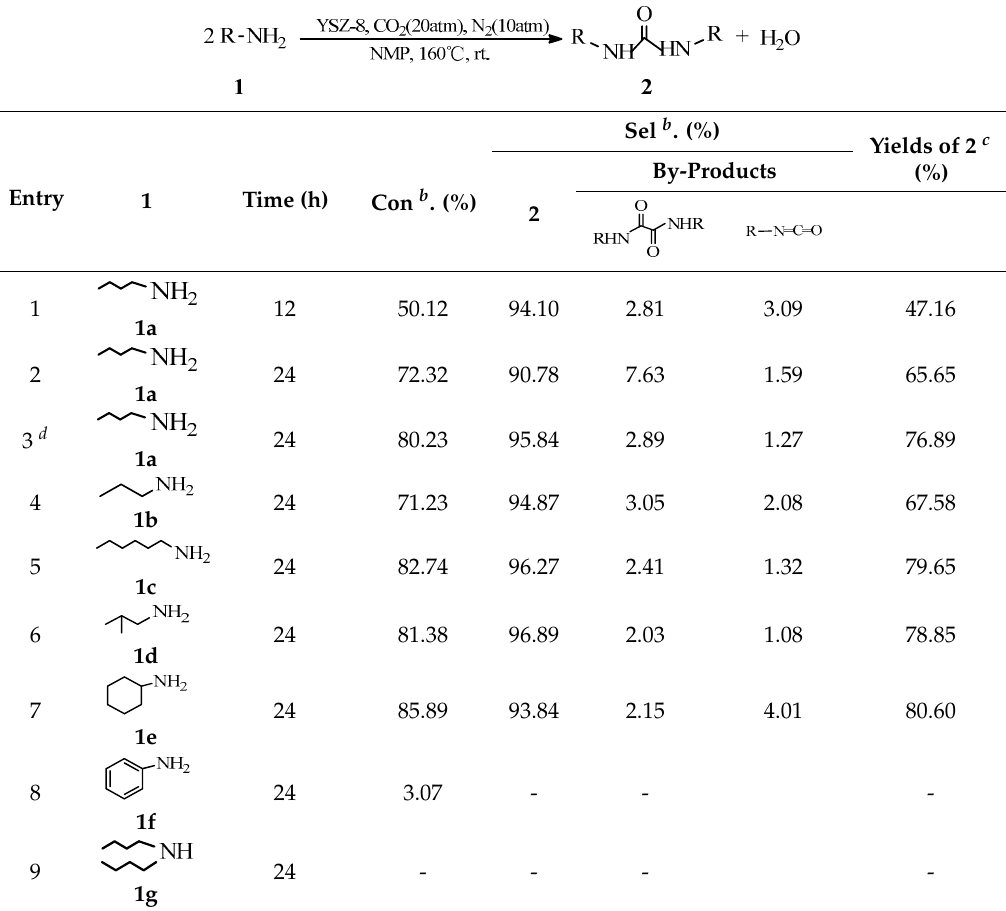
Table 2. Results for carbonylation of various amines ( 1 ) to the corresponding N , N’ -dialkylureas ( 2 ) with CO 2 a .